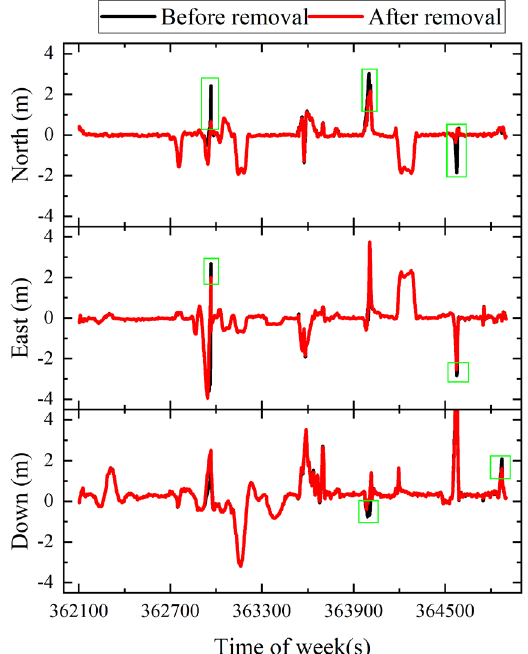
Figure 8. The effects of dynamic feature points removal on positioning accuracy.